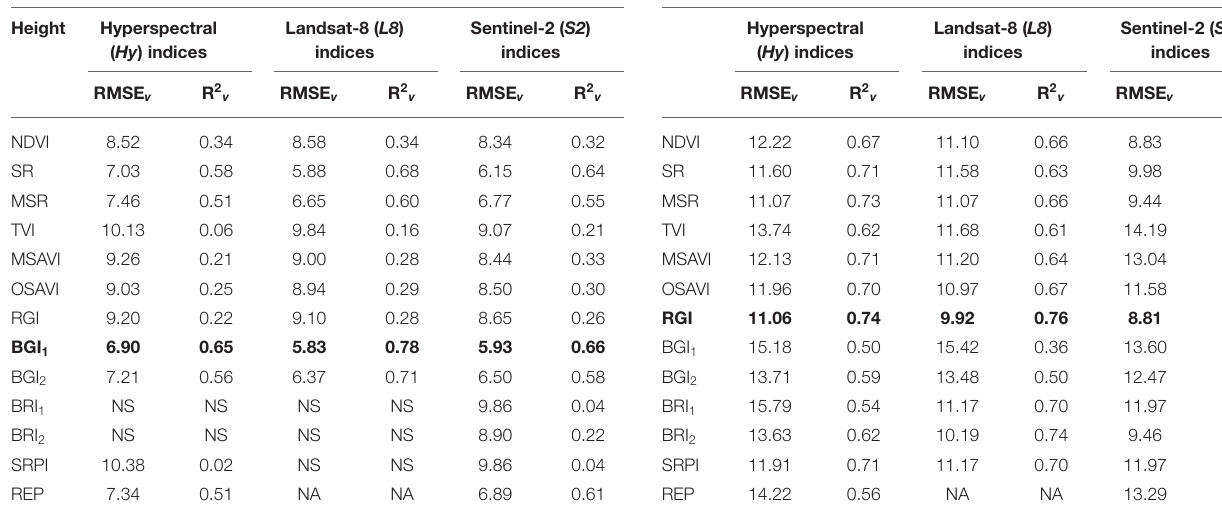
( Table 6 ). For S2 data, five out of 13 indices resulted in R 2 v < 0.50, with S2_BGI 1 performing as the least accurate (R 2 v = 0.30). Unlike canopy height, the resulting MLR models for canopy cover were consistently based on the same two VIs ( SR and RGI ;